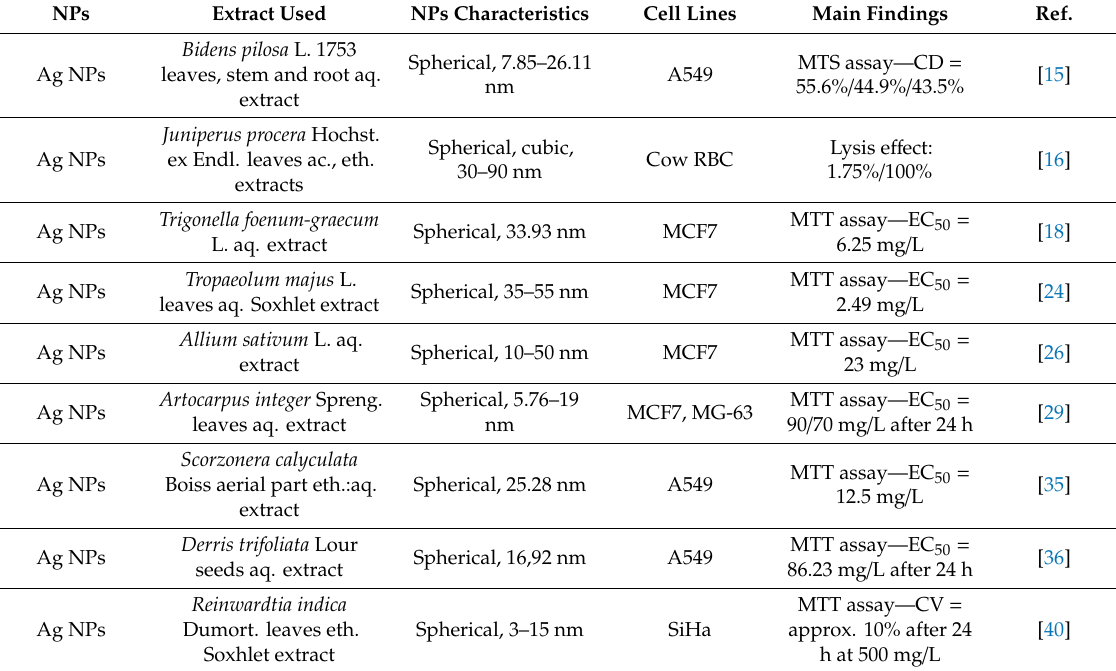
Figure 4. Antitumoral mechanism of nanoparticles (adapted from [73,81]). Table 3. Antitumoral potential of phytosynthesized silver and gold nanoparticles (as presented in studies published in 2019).